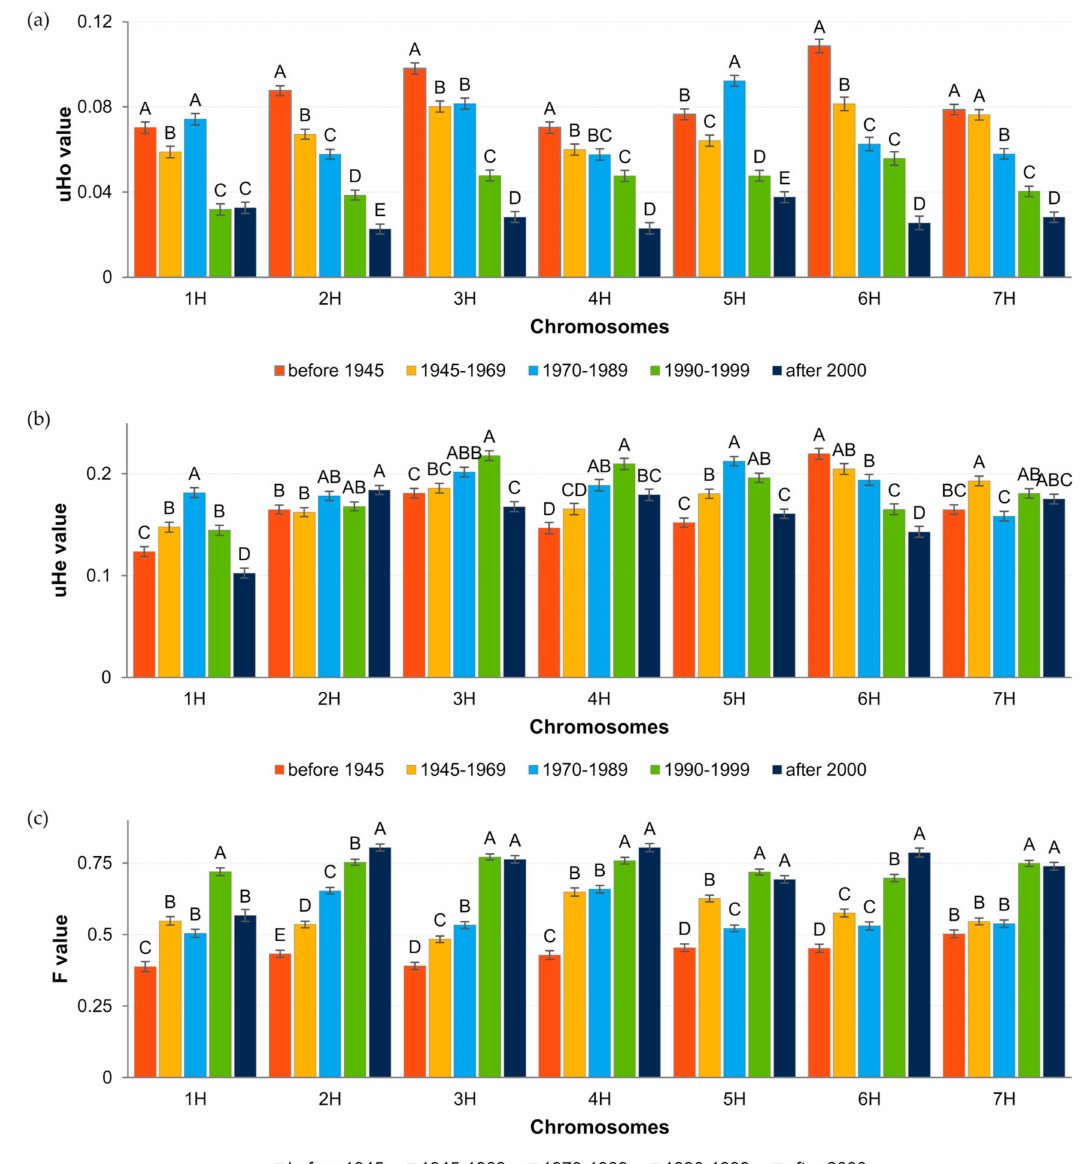
Figure 5. Summary of the diversity coefficients values for cultivar groups, assigned based on the breeding date considering chromosome localization. Letters above the bars in the graph indicate homogeneous groups determined by Tukey’s post hoc test. ( a ) observed heterozygosity (uHo); ( b ) expected heterozygosity (uHe); ( c ) inbreeding coefficient